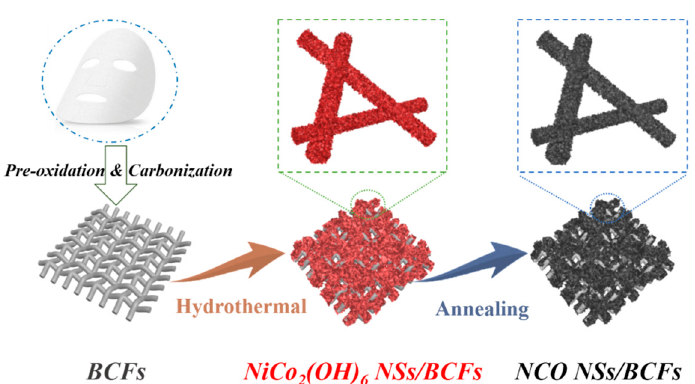
Figure 1. Schematic illustration of the synthesis of the composite consisting of NiCo 2 O 4 nanosheets grown vertically on a biomass-derived carbon fiber film (NCO NSs/BCFs).